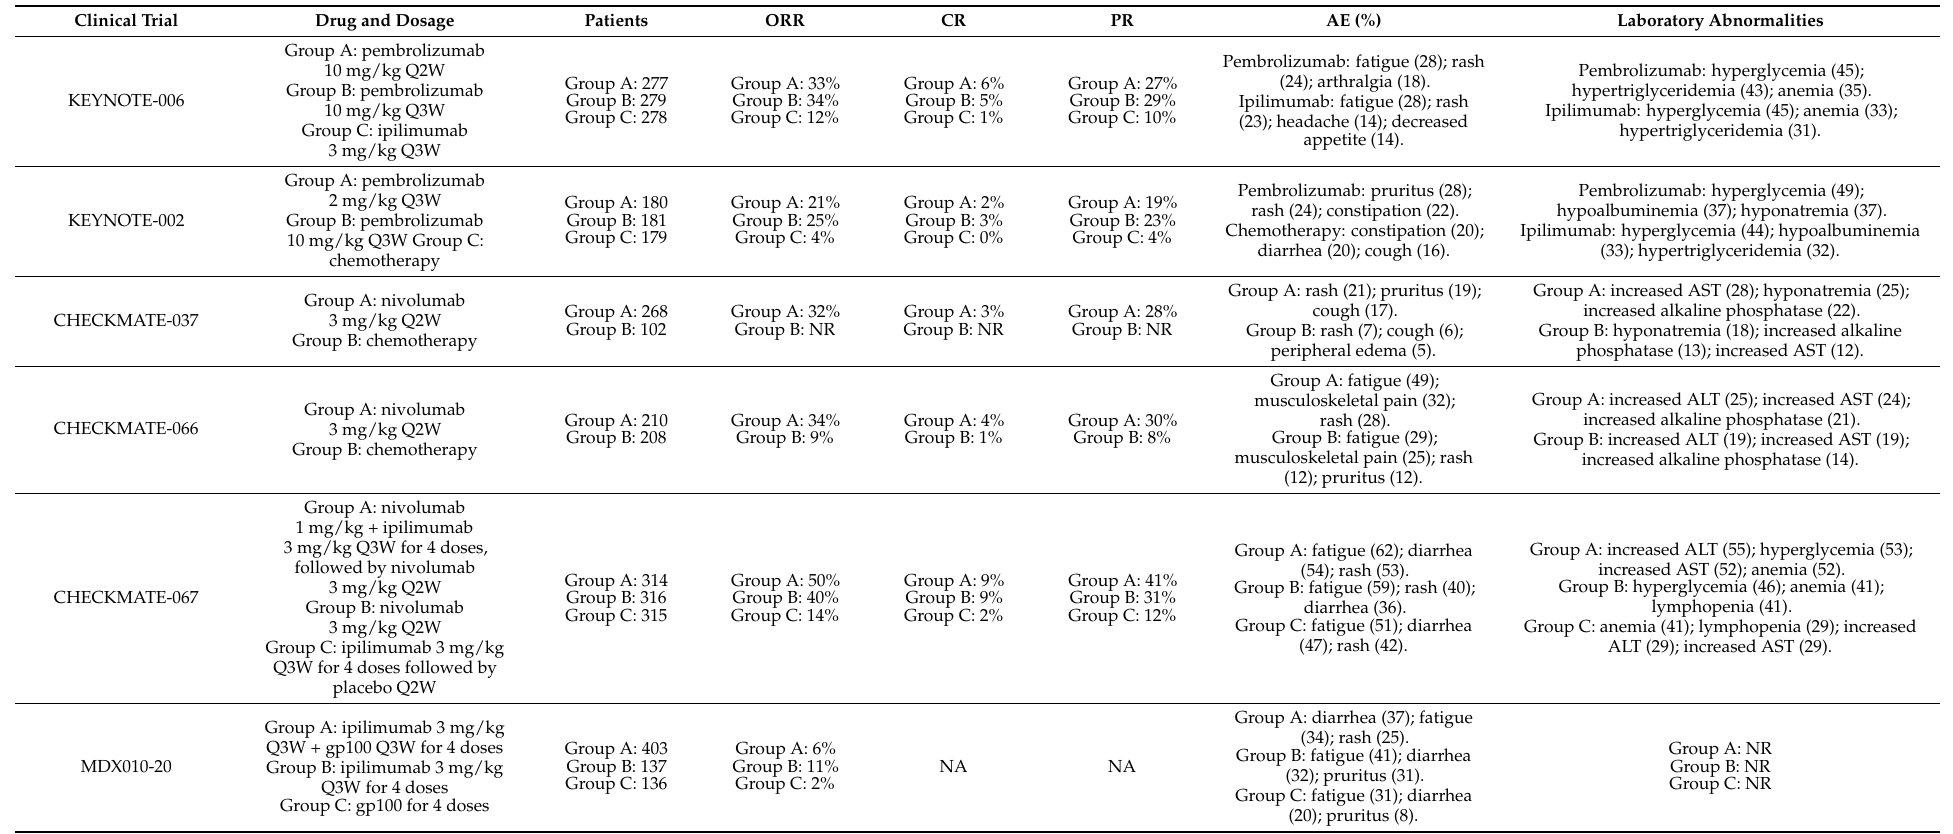
Table 1. Efficacy and safety of drugs currently approved for the management of metastatic or unresectable